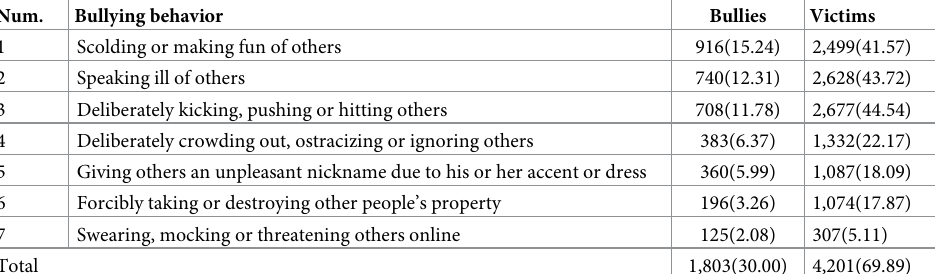
Table 2. Occurrence of different kinds of bullying behavior in primary schools in Luzhou City (n (%)).